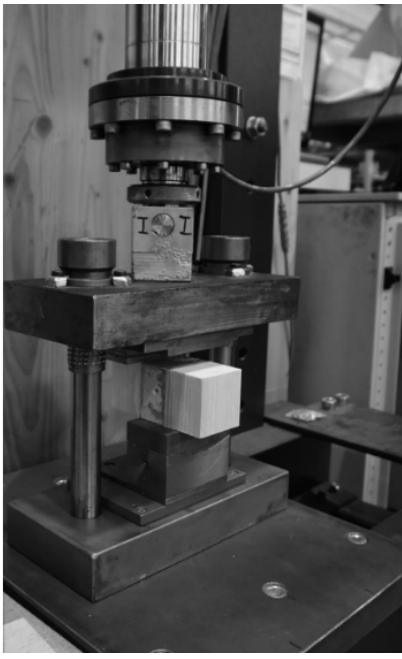
Figure 5. Experimental test setup for shear experi- ments [5].